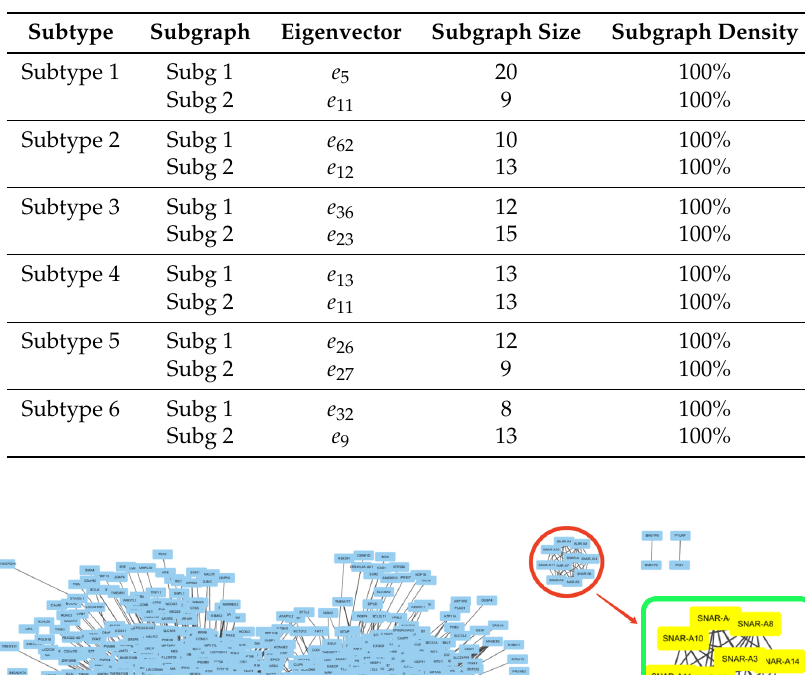
Table 3. Dense subgraphs detected by L 1 analysis.